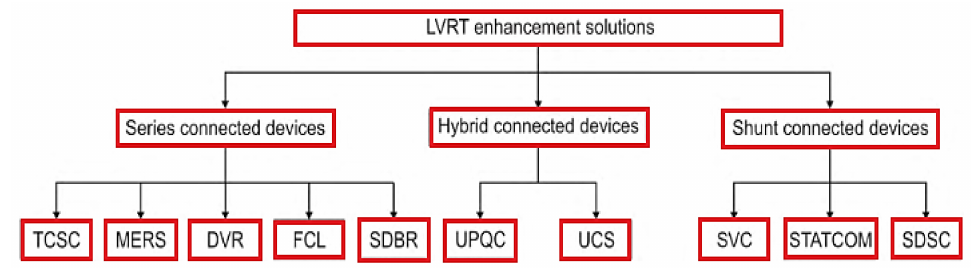
Figure 2. Fault ride through enhancement